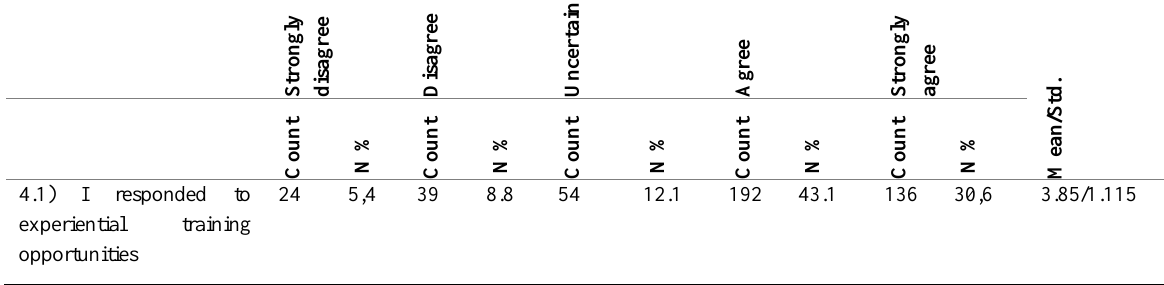
Table 4: Work-integrated learning